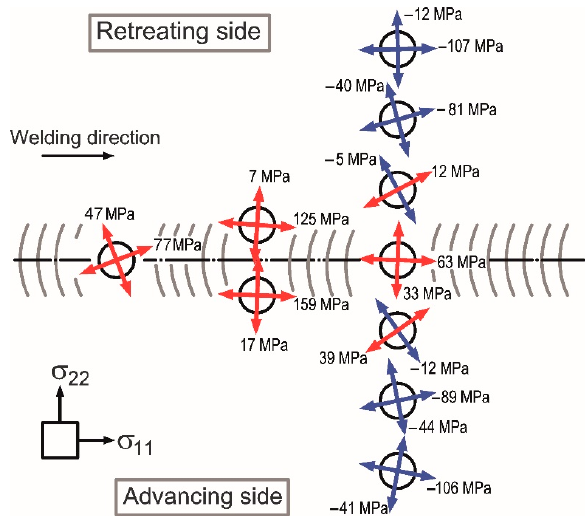
Figure 10. The directions and values of determined residual stresses in the FSW joint and its vicinity; σ 11 and σ 22 are the longitudinal and transverse stresses, respectively. Results obtained by hole-drilling method were used to compute the values of longitudinal stresses σ 11 and transverse stresses σ 22 . Nevertheless, in most cases, the values were obtained directly during the measurements because the directions of the main gauges (tensometers nos. 1 and 3) were convergent with the directions of searched stresses. The Equation (4) was used in other cases.